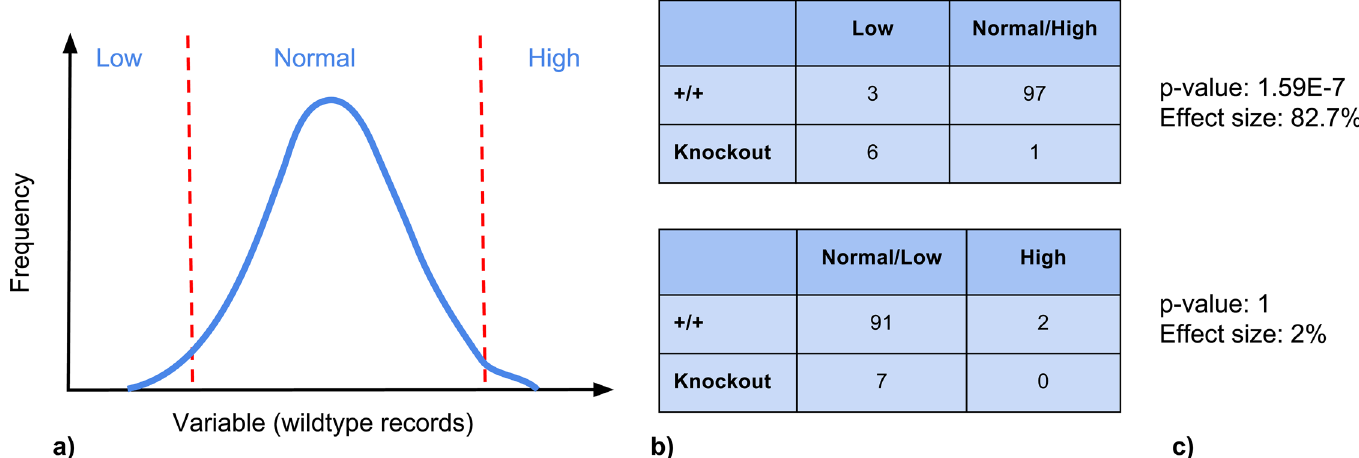
Fig 4. The Reference Range Plus method. a) Determining the thresholds for classifying the measures as low, normal or high based on the natural variation seen in the control data. b) Formation of a 2x2 count table following the classification of the measured animals. c) The observed proportions seen in tables (b) are compared with a Fisher Exact Test and effect quantified by calculating a change in penetrance in